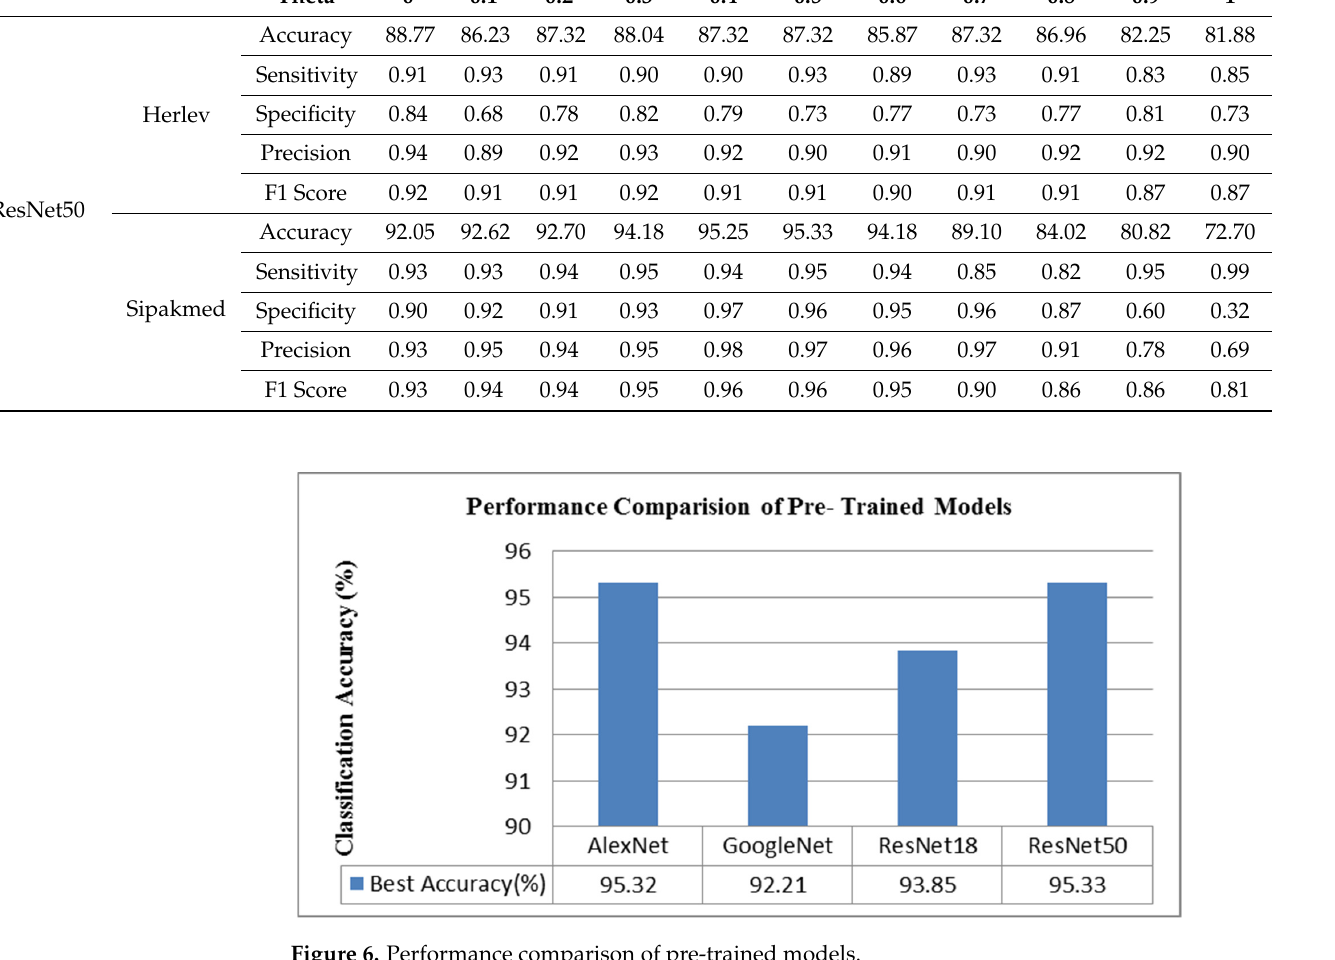
Figure 6. Performance comparison of pre-trained models.